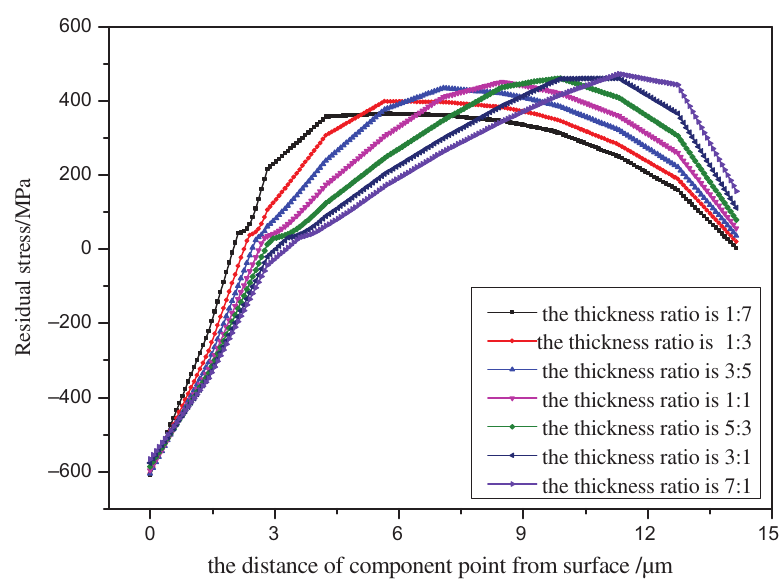
Figure 15: The effect of the Co-rich layer position on residual